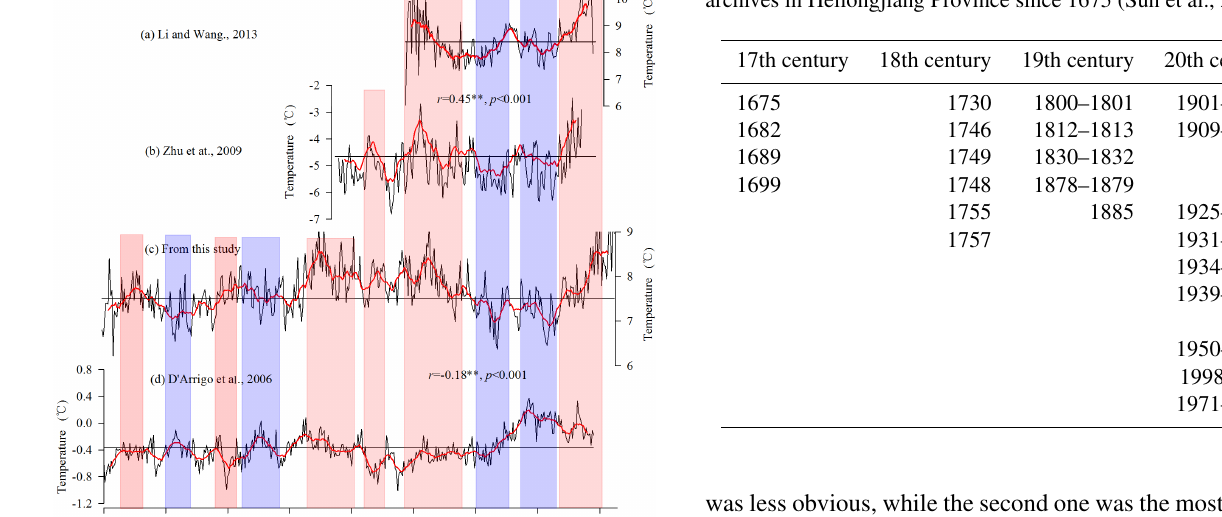
Table 5. Cold damage or frost disaster events recorded in historical archives in Heilongjiang Province since 1675 (Sun et al.,